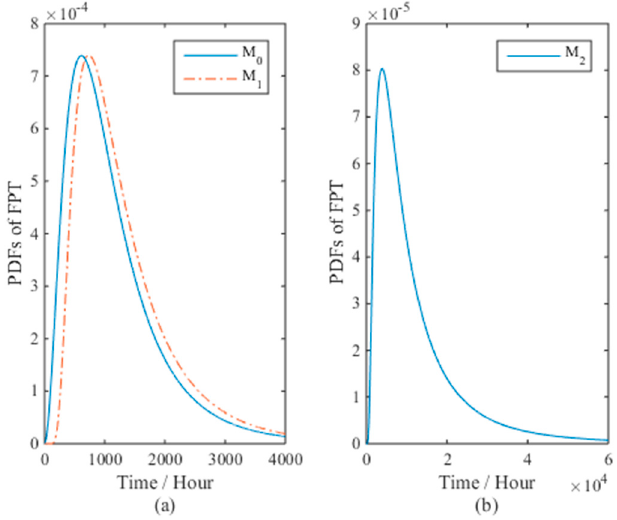
Figure 7. The PDFs of the FPT for different models in the LED case: ( a ) for M 0 and M 1 , ( b ) for M 2 .